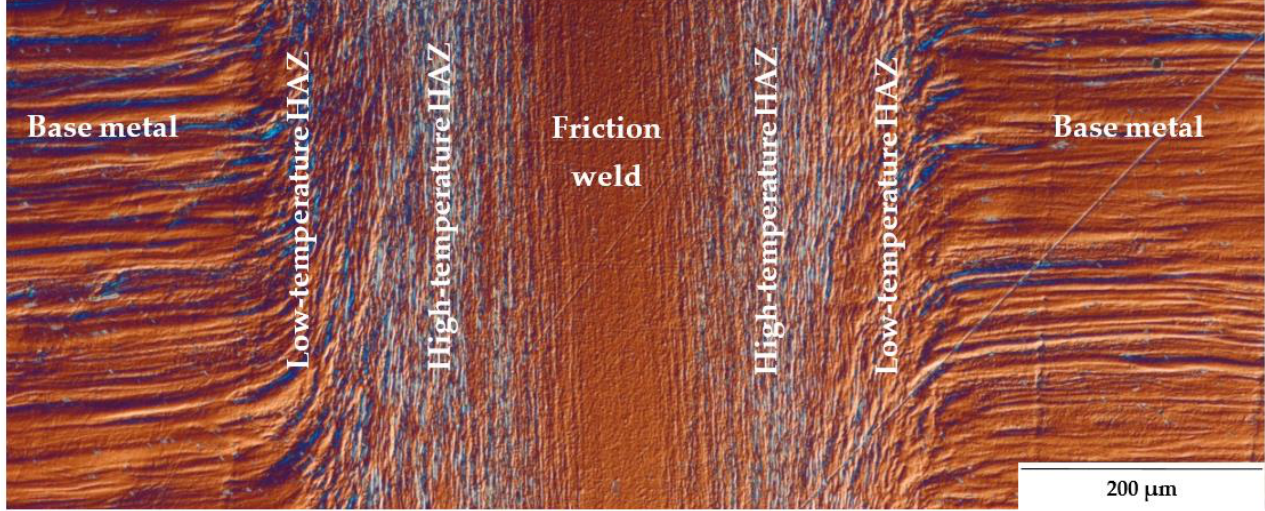
Figure 4. Microstructure of the friction joint from 316L steel after HE with Nomarski—Differential Interference Contrast (DIC).